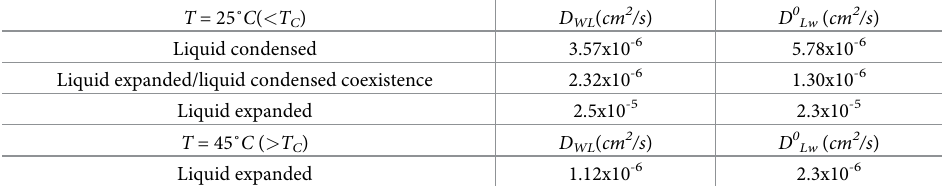
Table 2. Calculated coefficients for the diffusion of water in lipids (D wL ) and the diffusion of lipid (with its hydra- tion shell) in water (D Lw ) in the different regions of the surface pressure / are per lipid